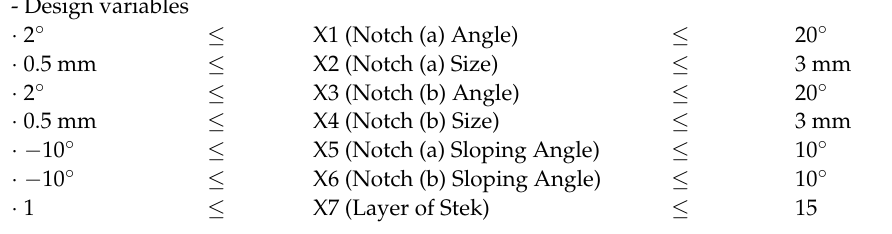
Table 4. Results of optimal design.